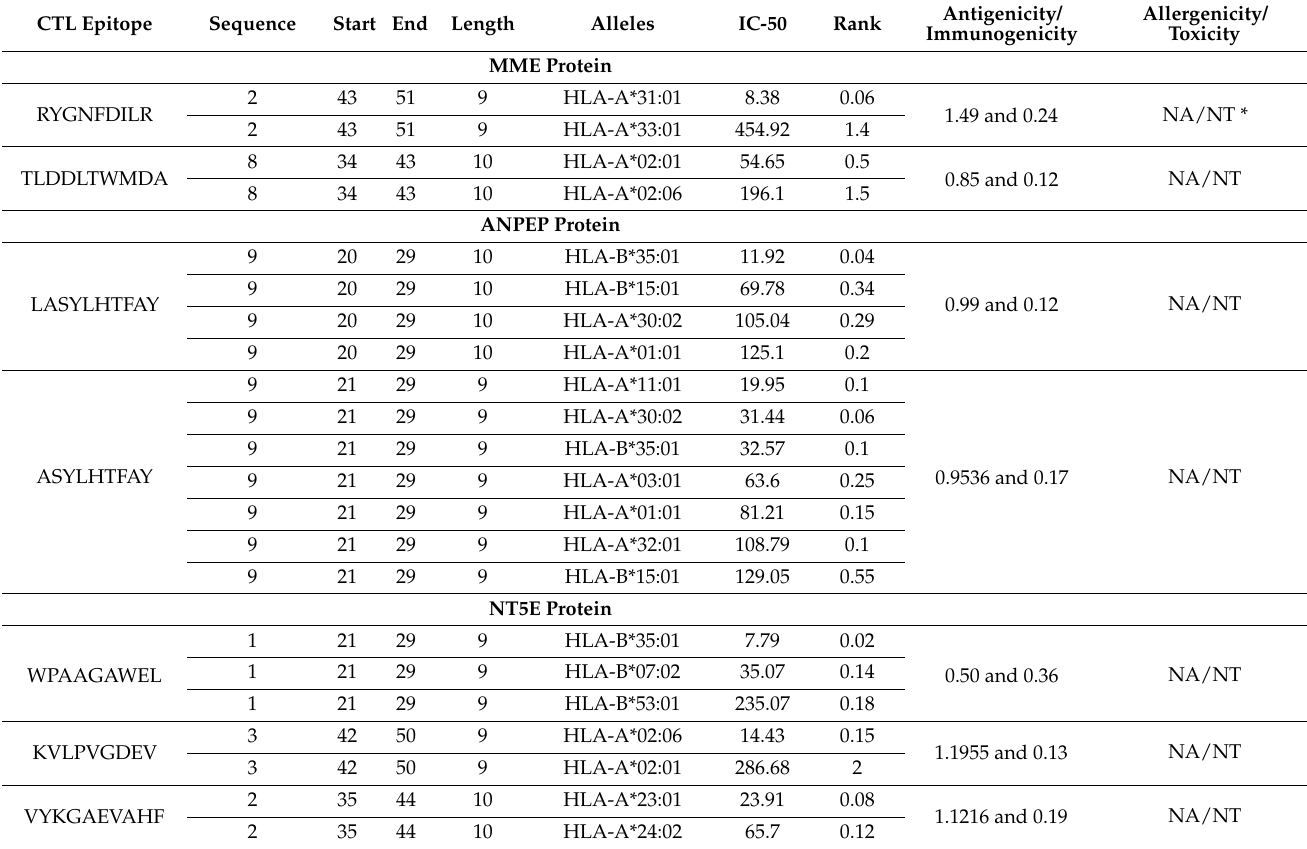
Table 1. List of CTL epitopes selected for design of vaccine